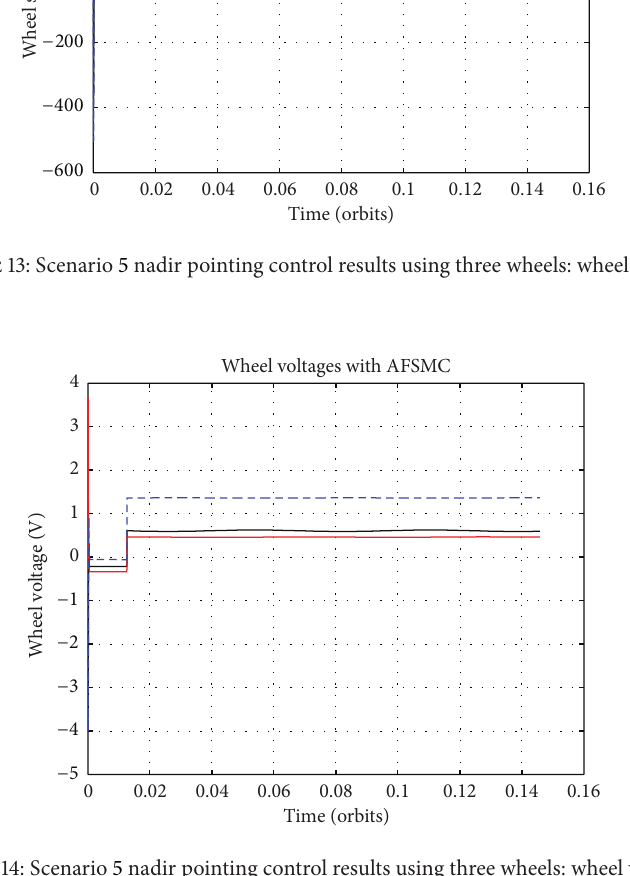
Figure 14: Scenario 5 nadir pointing control results using three wheels: wheel voltage.